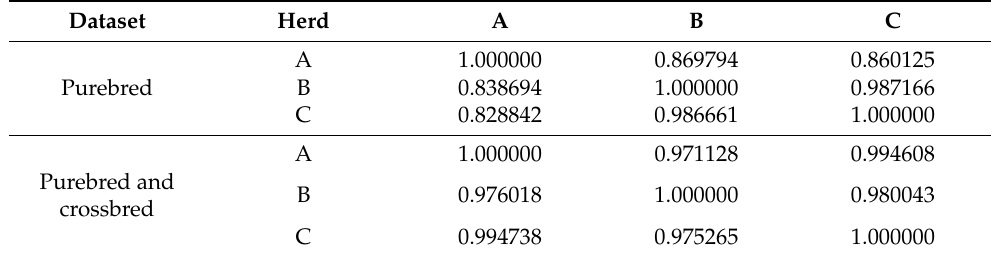
Table 5. Connectedness rating (CR) between herds for purebred and purebred and crossbred data.